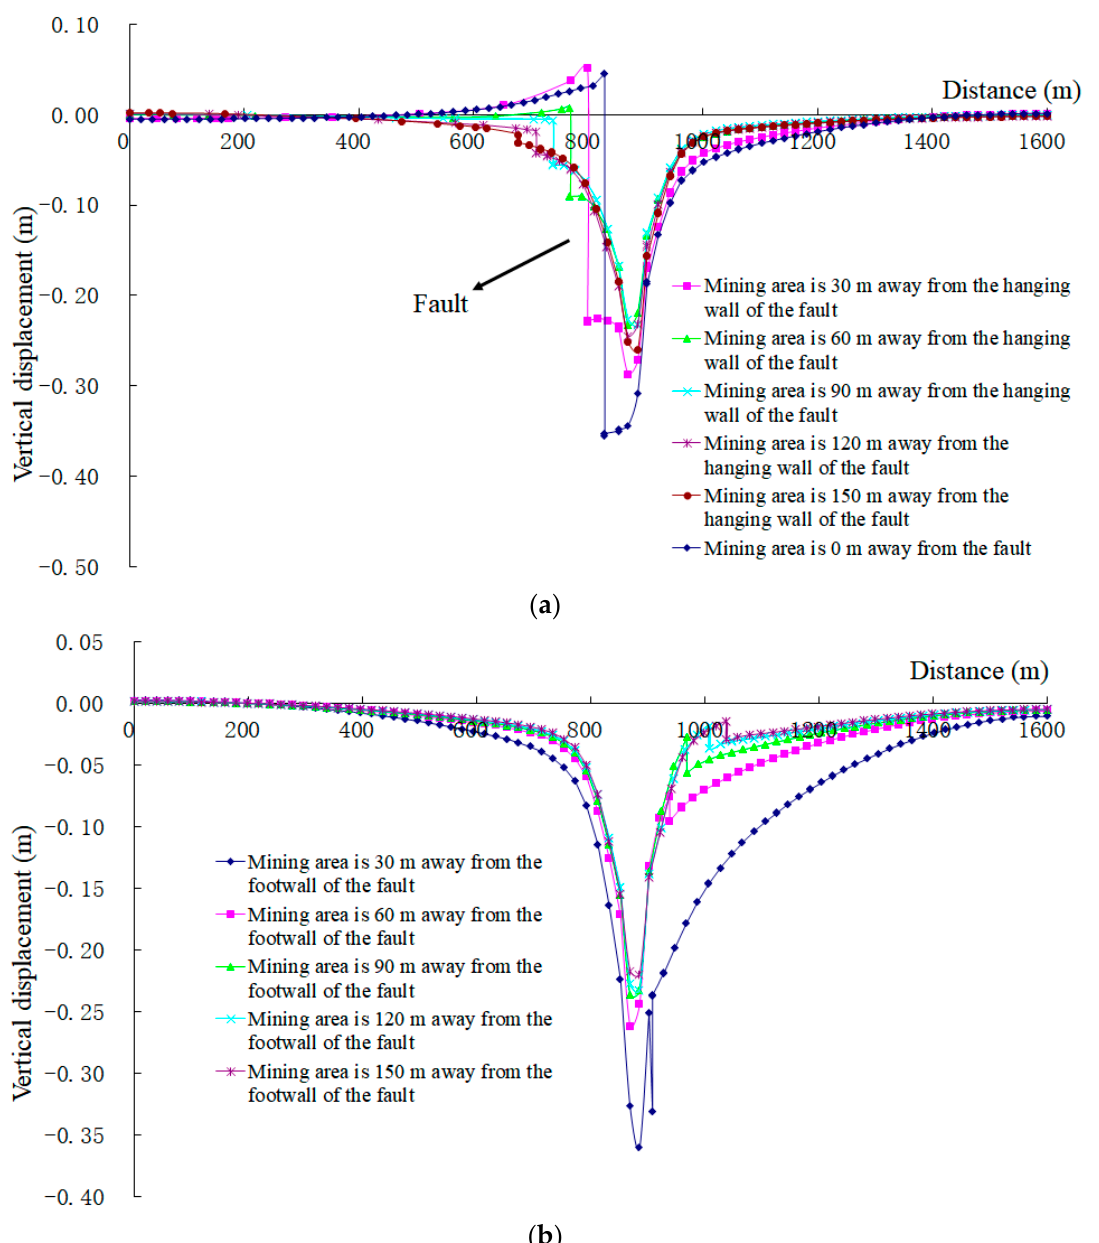
Figure 3. Nephogram of stress and displacement distribution of surrounding rock when the mining area is 0 m away from the fault (the fault cuts into the goaf), they should be listed as: ( a ) Maximum principal stress nephogram; ( b ) Vertical displacement nephogram.